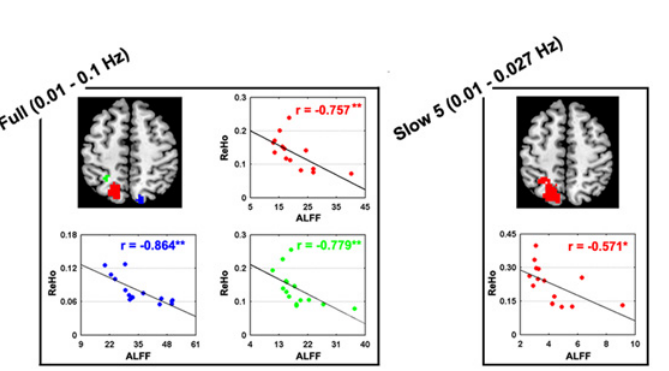
Fig 3. Relationships between ALFF and ReHo for regions showing abnormal ALFF and ReHo in patients. Significantly negative correlations were found between these two measures in stroke